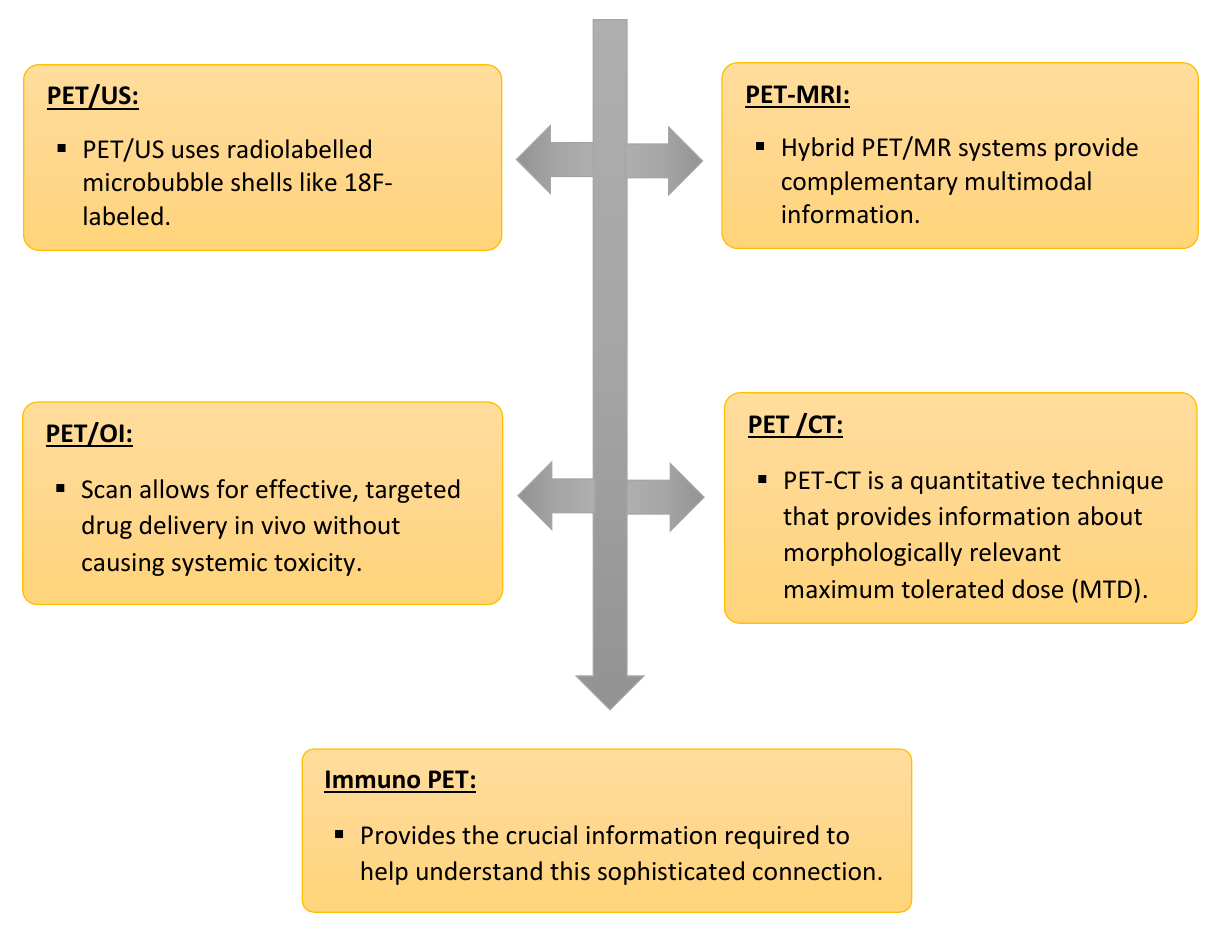
Figure 2. Positron Emission Tomography